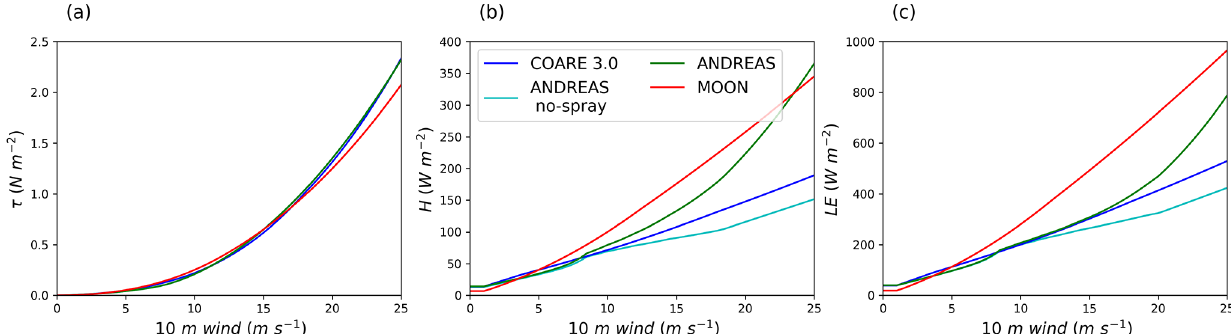
Figure 2. Turbulent fluxes of momentum (a) , sensible heat (b) and latent heat (c) as functions of the surface wind speed for each bulk pa- rameterization (COARE3.0 in blue, ANDREAS no-spray in cyan, ANDREAS in green and MOON in red). The computation was performed with SURFEX offline, with the air surface temperature fixed at 10 ◦ C, the sea surface temperature at 15 ◦ C, the relative humidity at 70% and the surface atmospheric pressure at